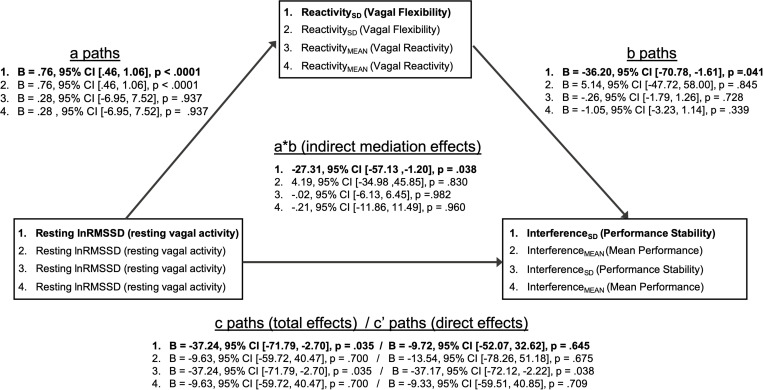
Summary of mediation models. Mediation models (1–4) test whether vagal flexibility and mean vagal reactivity mediated relations between resting vagal activity and performance metrics. The indirect effects (path a * path b) tested mediation. Two-tailed p-values and 95% confidence intervals for the indirect effects were computed using an approximate Bayesian Monte Carlo method (# simulations = 10,000). Statistics for path coefficients include unstandardized regression coefficients (B), two-tailed p-values, and 95% confidence intervals. Path a represents the relations of resting vagal activity to vagal flexibility and mean vagal reactivity. Path b represents the relations of vagal flexibility and mean vagal reactivity to performance stability and mean performance. Path c represents the total effect of resting vagal activity on performance metrics before accounting for mediator (vagal flexibility or vagal reactivity). Path c’ represents the direct effect of resting vagal activity on performance metrics after adjusting for mediator. Bolded text indicates that the indirect/mediational effect for that model was statistically significant (p < 0.05). There was a significant indirect effect of resting vagal activity on performance stability through vagal flexibility (mediator). All other indirect effects were not statistically significant (p > 0.05).